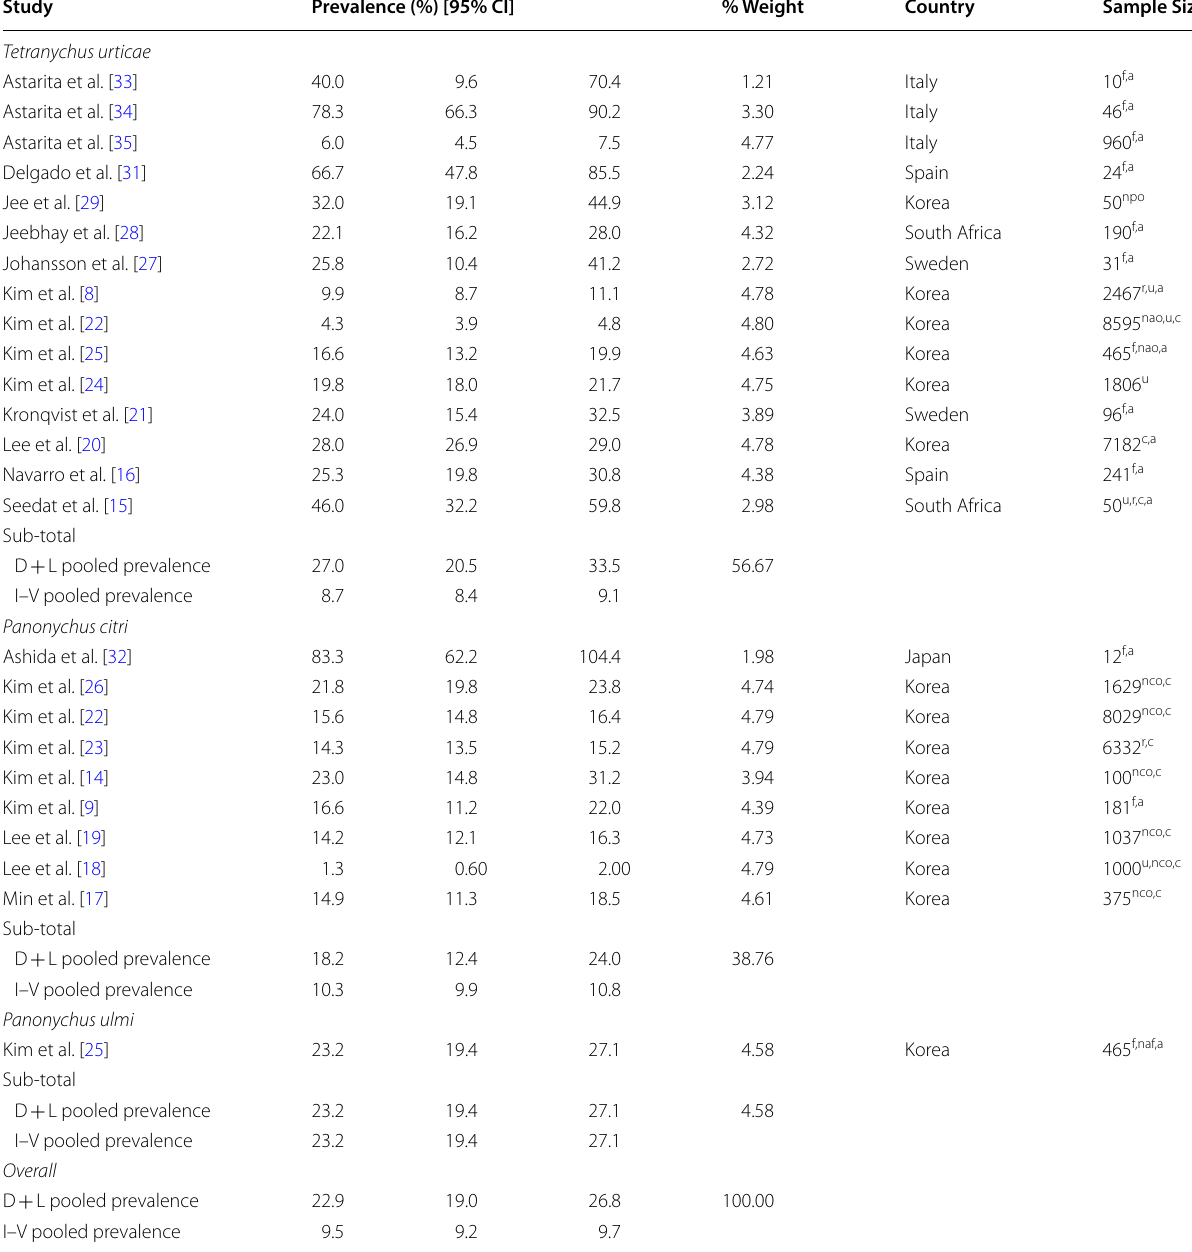
Populations considered in these studies: f, farmers (either outdoor or greenhouse workers); naf, living near apple farms; nco, living near citrus orchards; npo, living near pear orchards; r, rural (unspecified adjacency to specific crop types); u, urban; c, children; a,